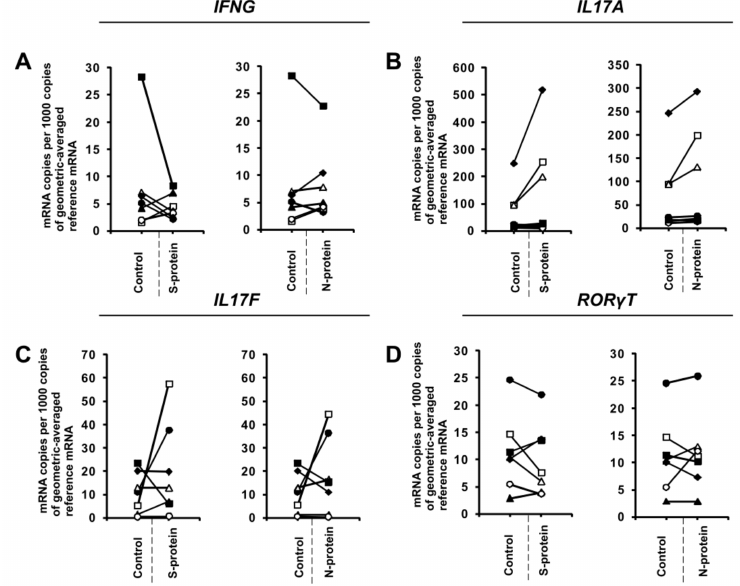
Figure 3. SARS-CoV-2-specific gene expression in CD4 + cells isolated from healthy, unexposed donors that were di ff erentiated into Th17 lymphocytes. mRNA expression of IFNG ( A ), IL17A ( B ), IL17F ( C ), and ROR γ T ( D ) genes in CD4 + cells di ff erentiated towards Th17 cells in the presence of 1 µ g / mL SARS-CoV-2 proteins S (spike) and N (nucleocapsid) for 5 days determined by real-time RT-PCR and normalized to averaged reference mRNA levels of the housekeeping genes HPRT1 , HMBS , and RPL13A . “Control” denotes cells cultured in the absence of SARS-CoV-2 proteins for 5 days, and “S-protein” or “N-protein” denotes cells cultured in the presence of SARS-CoV-2 protein (S or N, respectively) for 5 days. Control values are the same for both conditions (S and N proteins). Straight lines connecting two points (control and given protein) identify samples from a specific donor. Data show individual values for seven independent donors ( n =